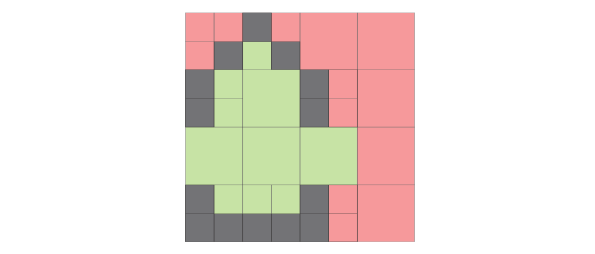
Figure 5: Occupied nodes (grey), interior empty nodes (green), exterior empty nodes